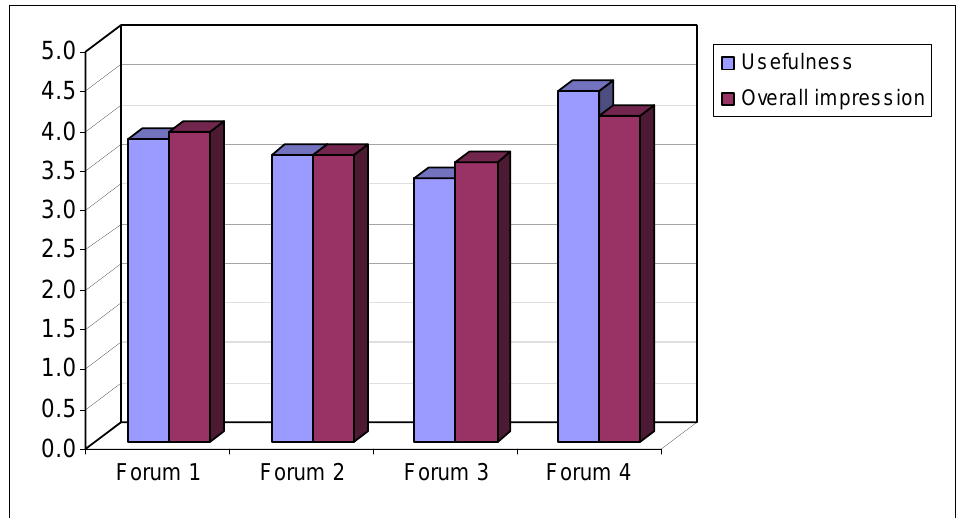
Figure 3. The participants’ average degree of